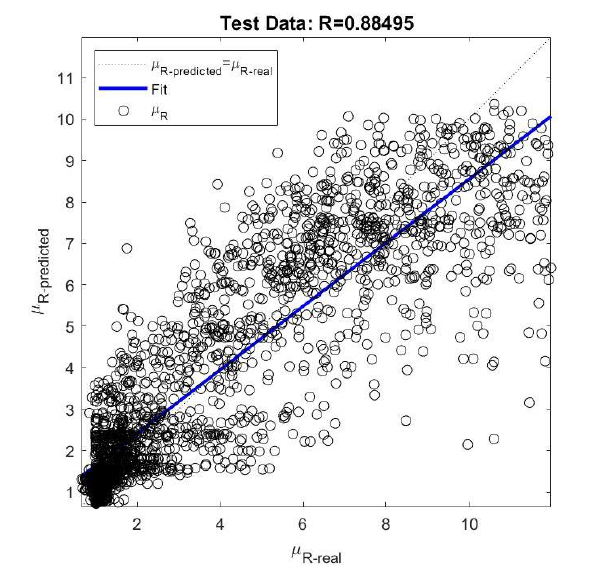
Figure 16. Correlation between the real and predicted values in training data (FCM